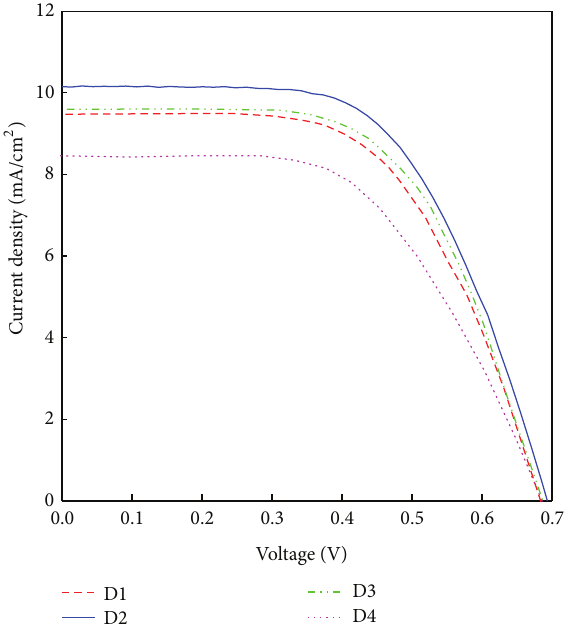
Figure 4: Photocurrent-voltage curves of chitosan sol-based